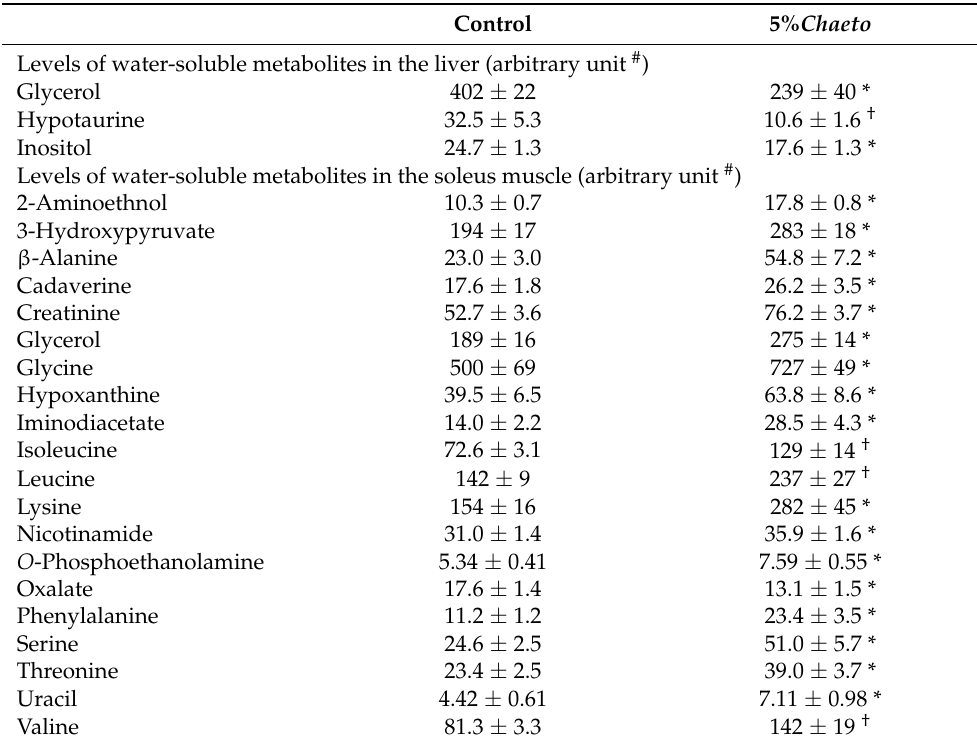
Control 5% Chaeto